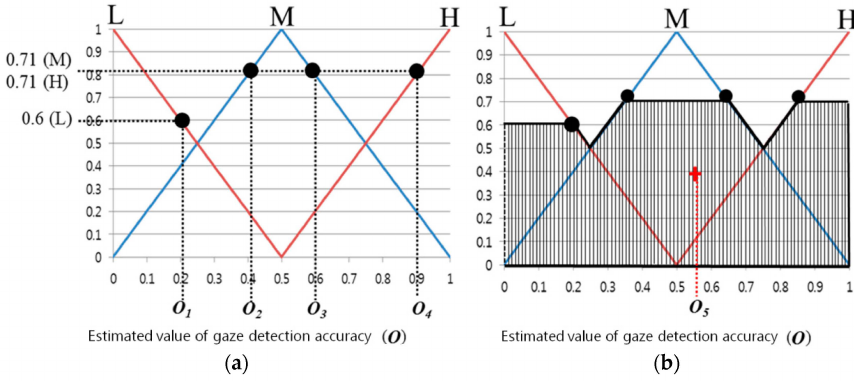
Figure 10. Examples of output value results through various defuzzification methods when an inference value is input: ( a ) FOM, LOM, MOM, MeOM, and ( b )